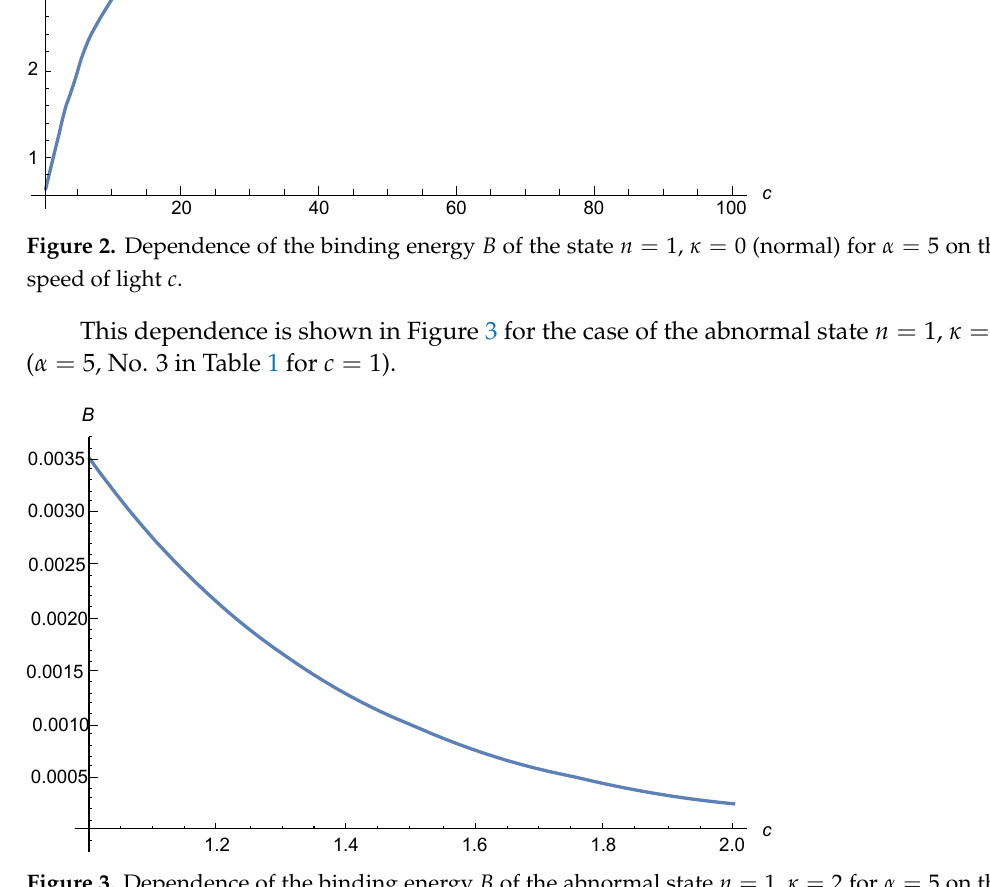
Figure 3. Dependence of the binding energy B of the abnormal state n = 1, κ = 2 for α = 5 on the speed of light c